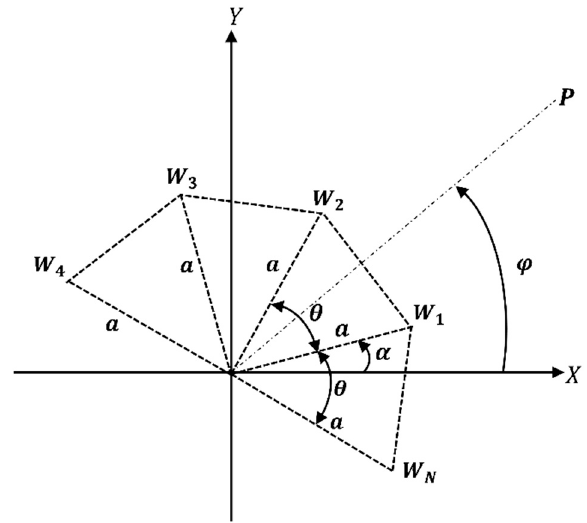
Figure 6. Schematic diagram of dipole placement in a regular polygon.